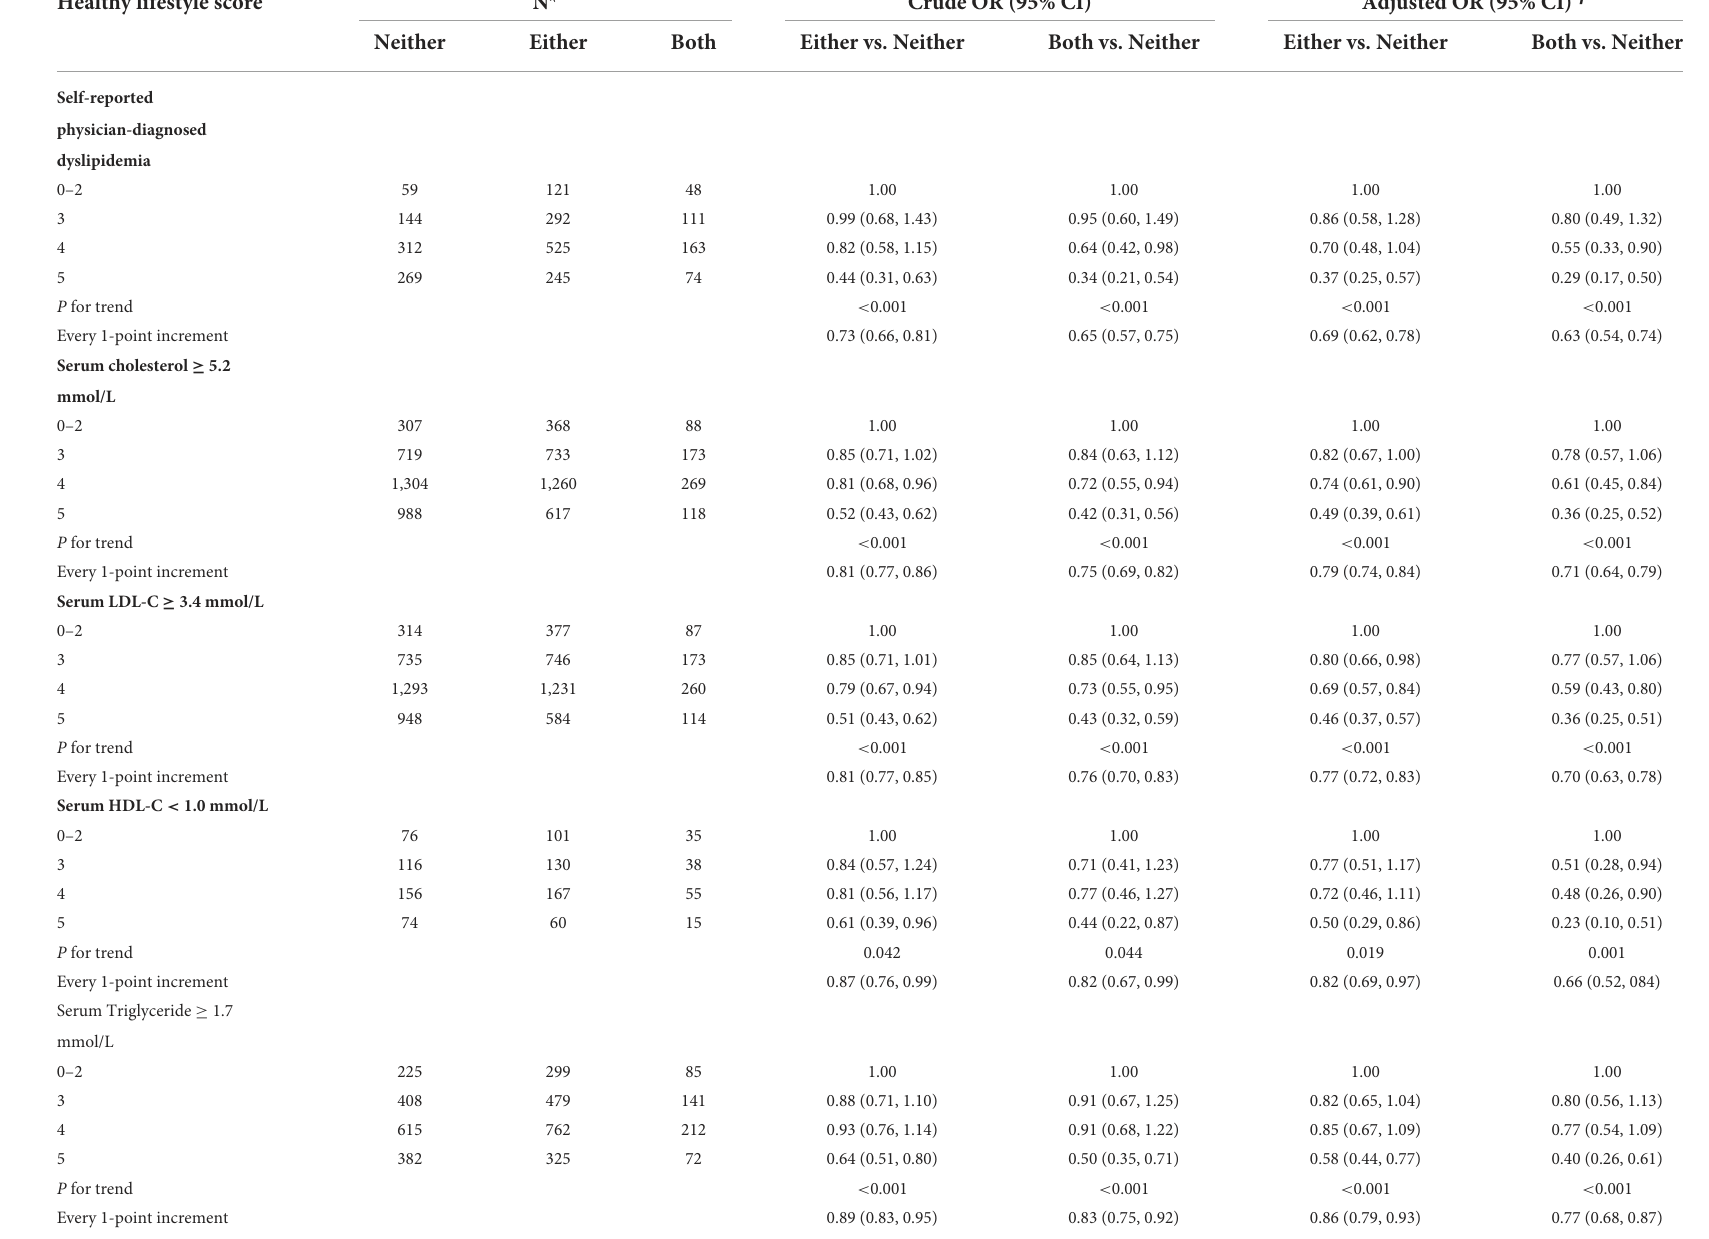
TABLE 6 Association between healthy lifestyle score and the risk of comorbidity of hypertension and T2DM according to different dyslipidemia definitions. Healthy lifestyle